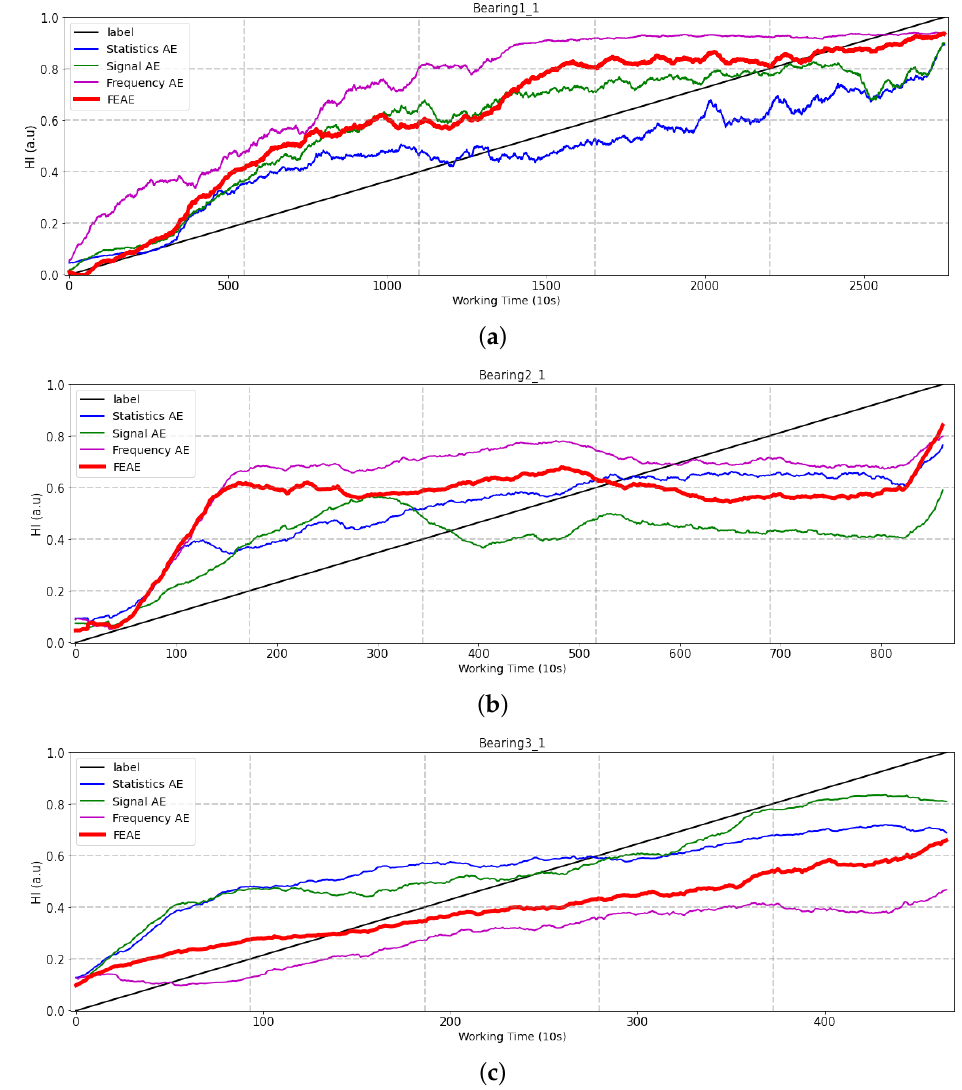
Figure 10. Comparison of experiment results of single-input models. ( a ) Test bearing1_1, ( b ) Test bearing2_1, ( c ) Test